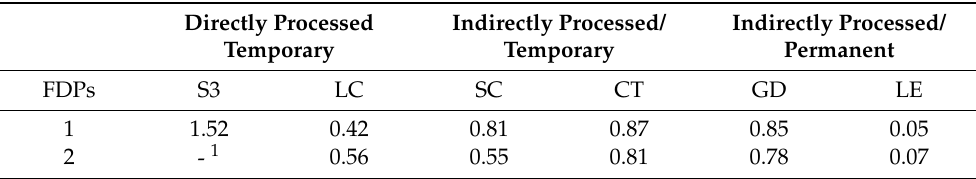
simulation in combination with thermocycling.